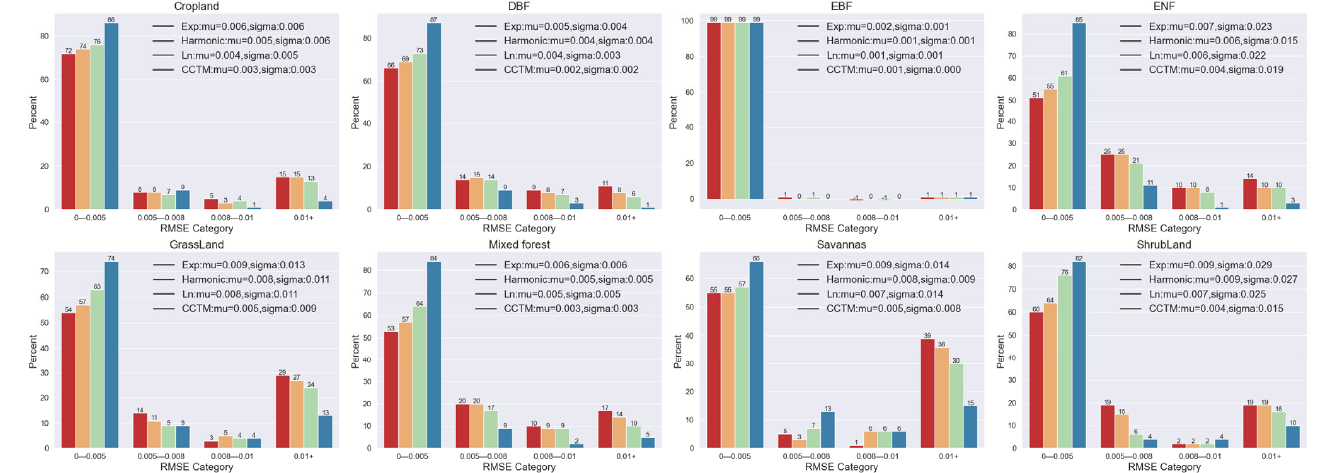
Figure 10. RMSE of reconstructed MSR time series data after smoothing for different landcover types. The frequency is the percentage of the certain RMSE range, and different landcover types may have different RMSE categories.